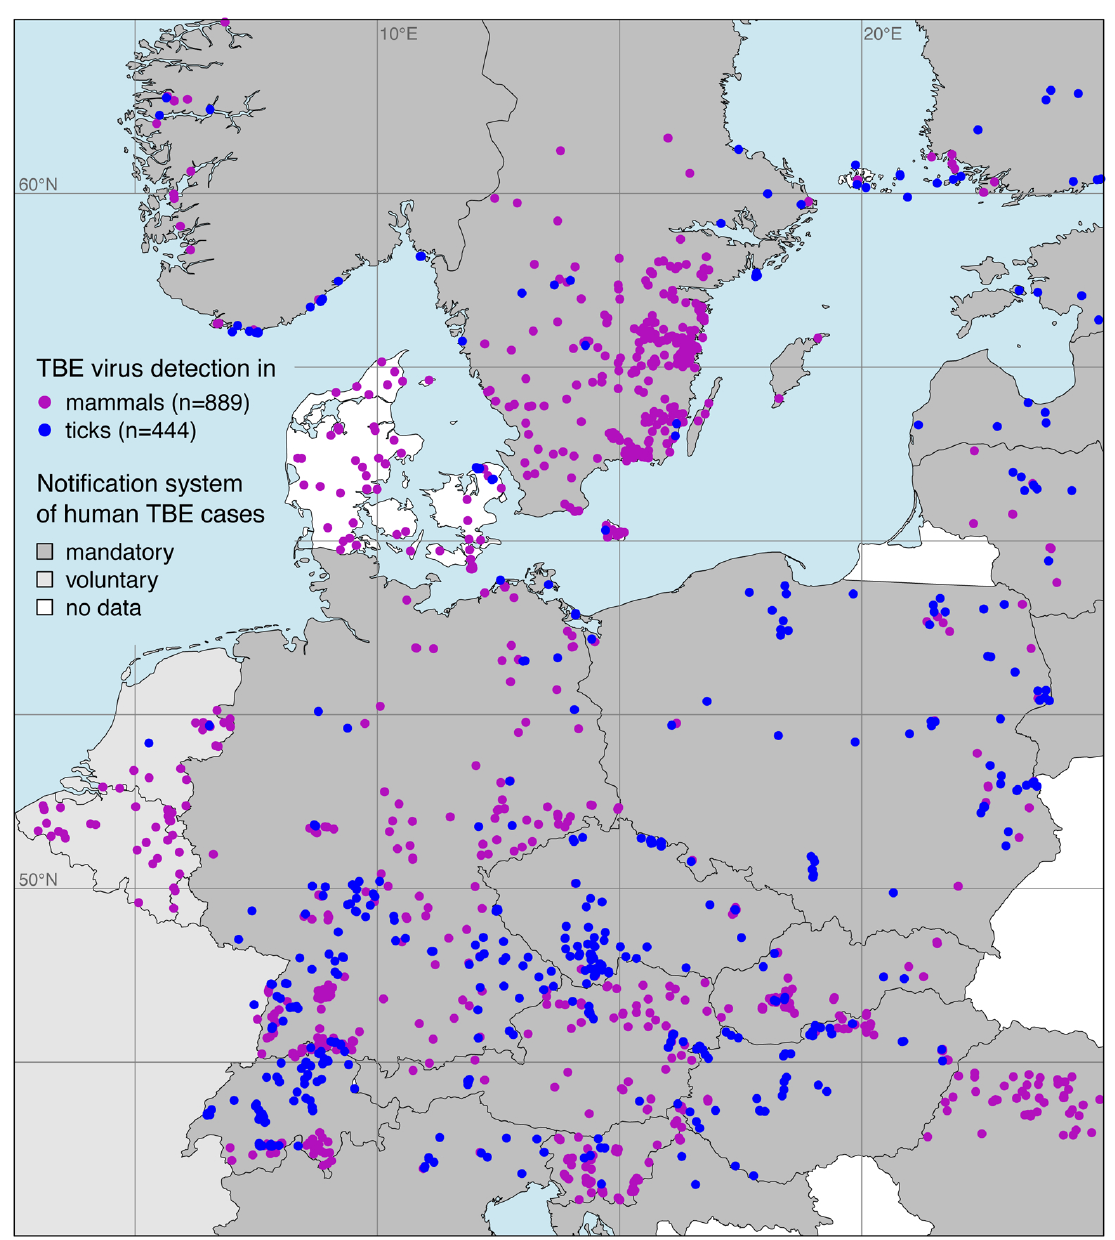
Figure 2. Georeferenced tick-borne encephalitis (TBE) virus detections in ticks (blue), mainly the castor bean tick Ixodes ricinus , and endothermic mammals except for humans (purple). Additionally, the sort of national notification system for human TBE cases is